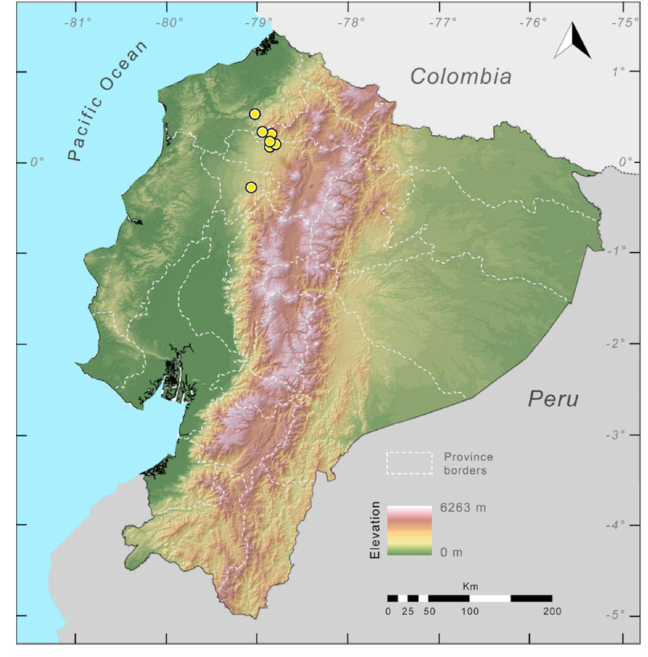
Figure 206. Distribution of Sachatamia orejuela in Ecuador (yellow